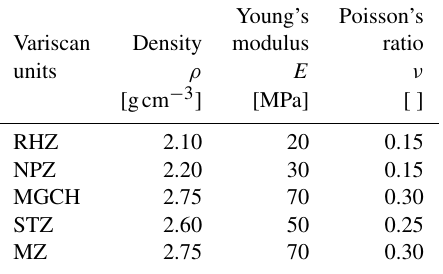
Table 3. Material properties used for the scenario using realis- tic rock properties for Variscan basement units; properties are es- timated based on Turcotte et al. (2014). MGCH = Mid-German Crystalline High, MZ = Moldanubian Zone, NPZ = Northern Pyl- lite Zone, RHZ = Rheno-Hercynian Zone, STZ = Saxo-Thuringian Zone.